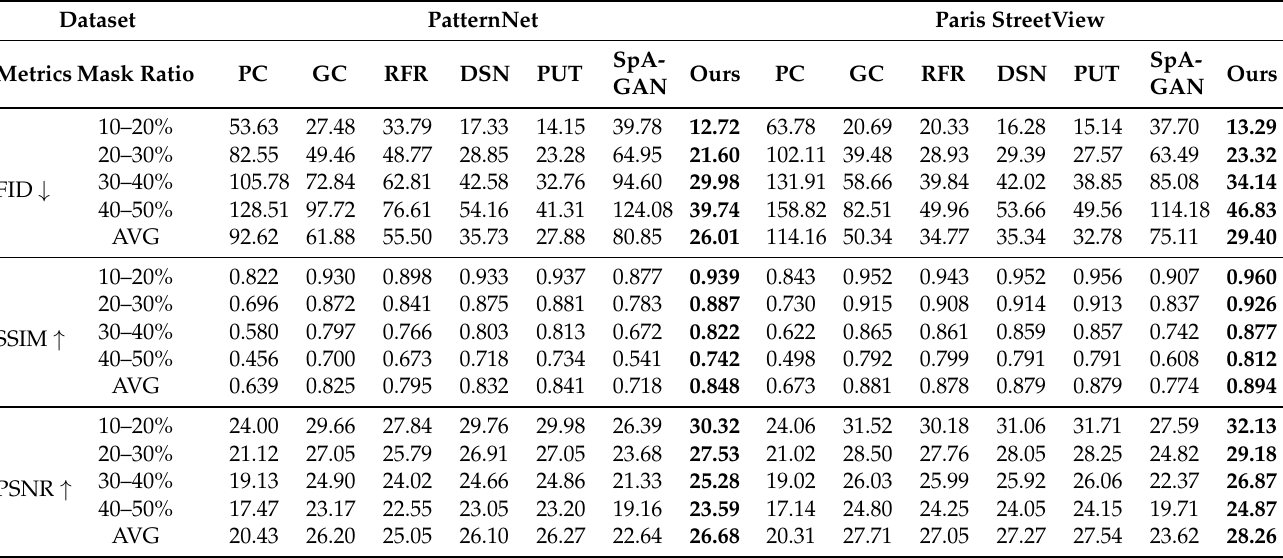
Table 2. Numerical comparison of the PatternNet and Paris StreetView